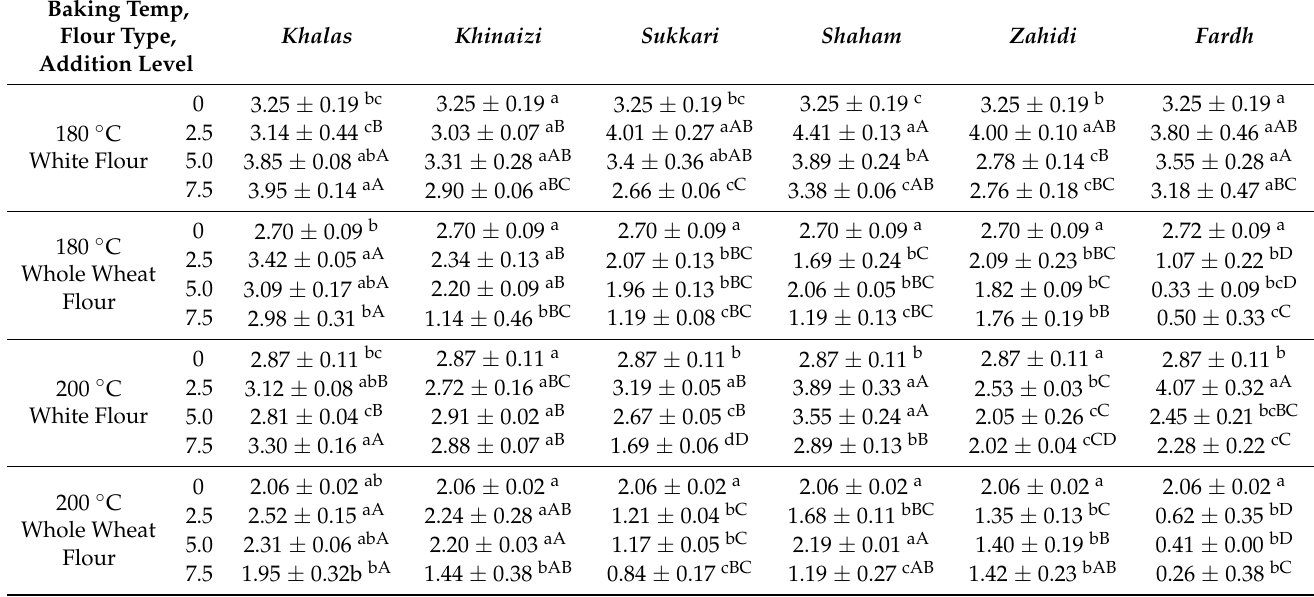
Table 2. Moisture content of cookies 1 .